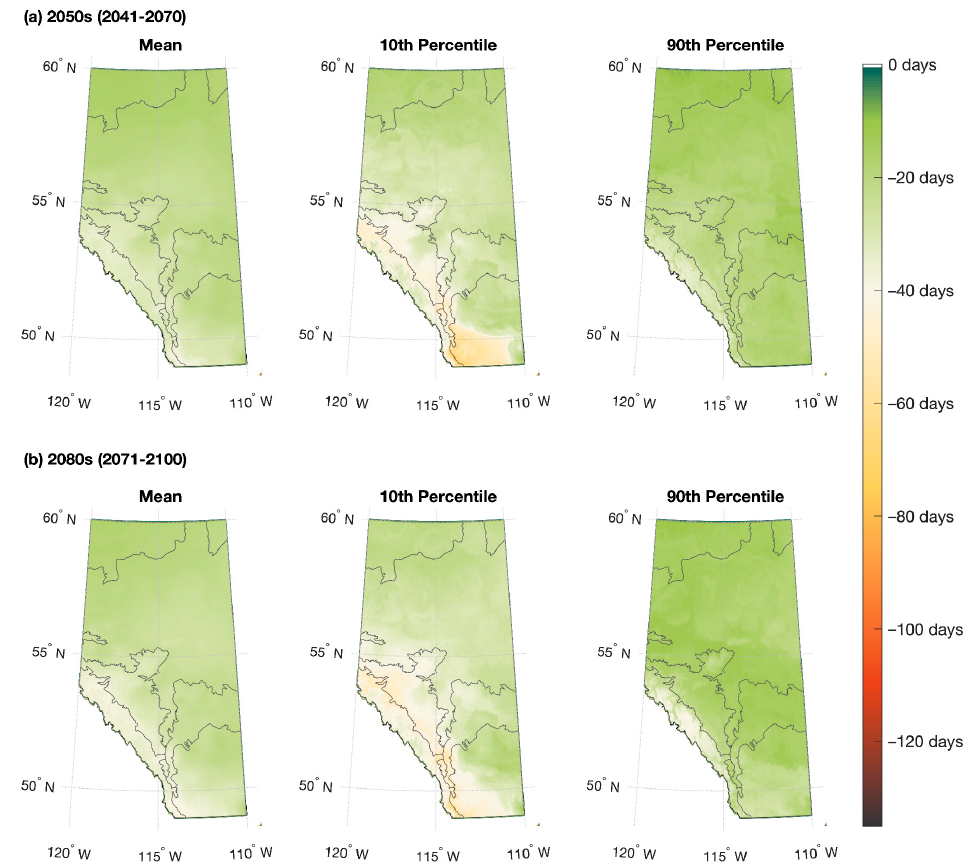
Figure 6. Projected change in winter duration—mean, 10th percentile (earliest), and 90th percentile (latest) between the historic period (1950–2017) and ( a ) 2050s (2041–2070) and ( b ) 2080s (2071–2100) for RCP 4.5.